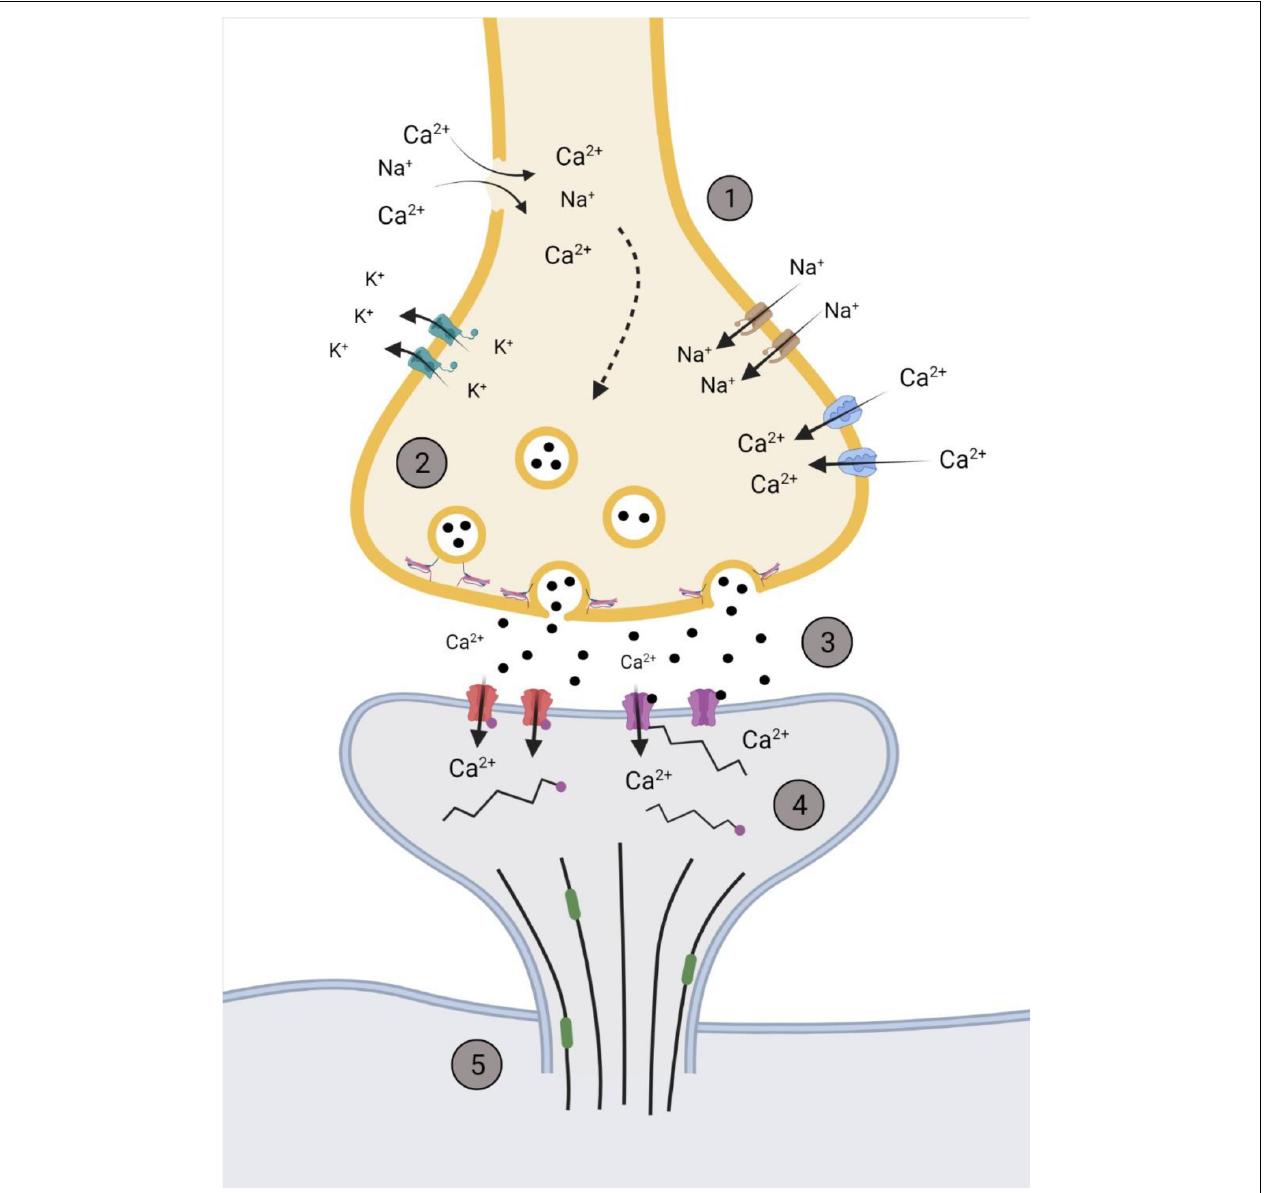
FIGURE 2 | Representation of the synapse within the hyperacute phase after impact. (1) Membrane permeability increases soon after impact through the influx/efflux of ions via voltage gated channels or rupturing of the pre-synaptic membrane. (2) The increase in Ca 2 + primes glutamate filled vesicles and increases the rate of fusion and release of glutamate. (3) Increased and sustained release of glutamate (black dots) into the synaptic cleft activates NMDAr NR2B subunits (purple) and increases post-synaptic concentrations of Ca 2 + . This activates various kinases that phosphorylates AMPA GluR1 subunits (red), further promoting the influx of Ca 2 + . (4) Post-synaptic cytoskeleton alterations occur through phosphorylation (pink dots), with disinhibition of remodeling proteins, such as end-binding protein 3 (green), occurring to allow for the restructuring of the dendritic spine cytoskeleton. (5) Downstream cascades from the influx of Ca 2 + alter microtubule dynamics within the cytoskeleton of the neuron. Created with